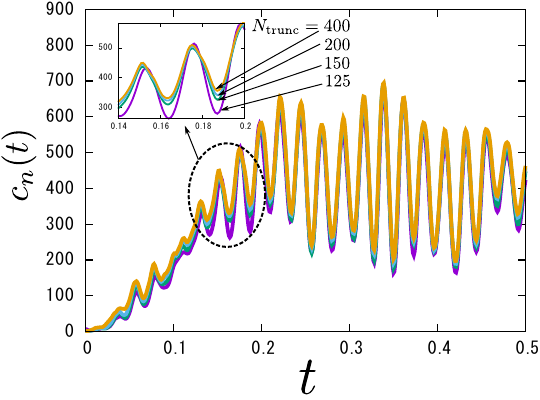
Figure 13 . The microcanonical OTOC of the stadium billiard for n = 100. The truncation is varied as N trunc = 125 , 150 , 200 ,